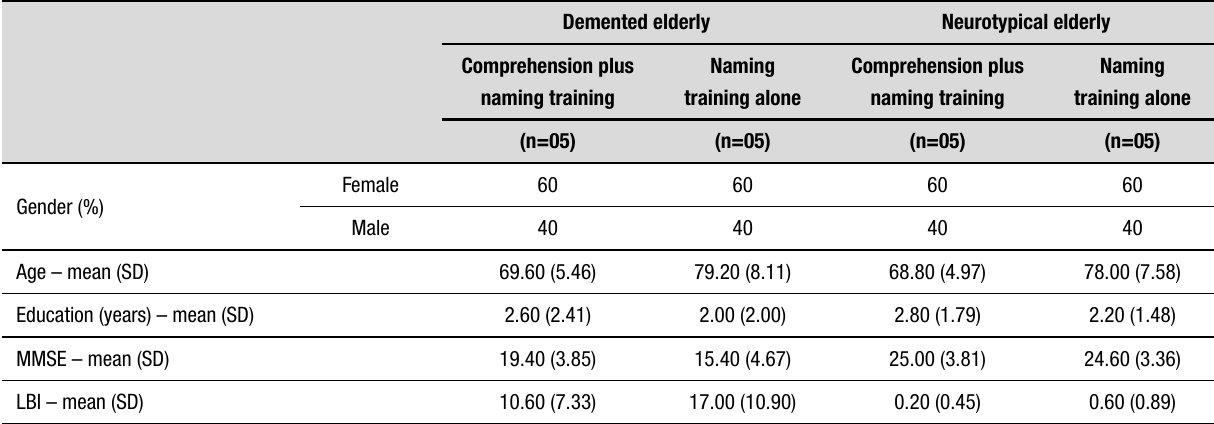
Table 1. Demographic and clinical data of demented and neurotypical elderly that participated in one of the two types of naming training